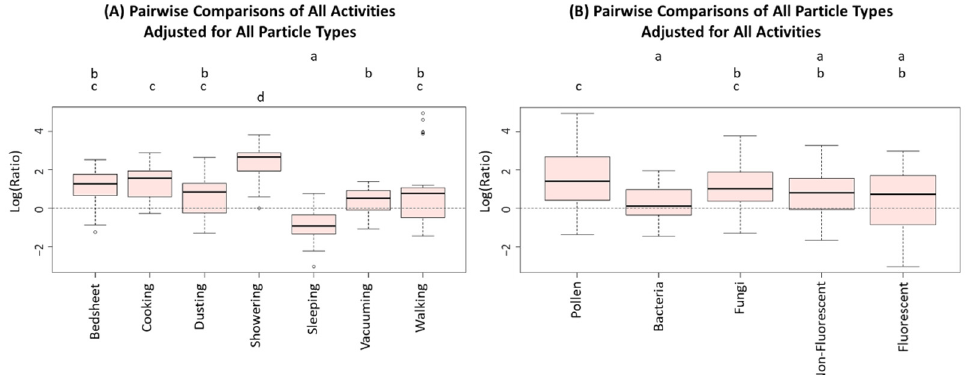
Figure 2. The Compact Letter Display (CLD) graphs portraying pairwise differences between ( A ) Activities, and ( B ) Particle Types. The data behind the comparisons are the natural-log transformed concentration ratios. In each CLD graph, the five-point box plot shows the minimum, first quartile, median, third quartile, and maximum of 25 data points for each activity (except sleeping, n = 20), and 34 data points for each particle type. The dotted line in each CLD graph shows log-ratio of zero (or equivalent anti-log ratio of one). Any two treatments receiving the same letter at the top of the graphs are not significantly different as per Tukey’s HSD method.